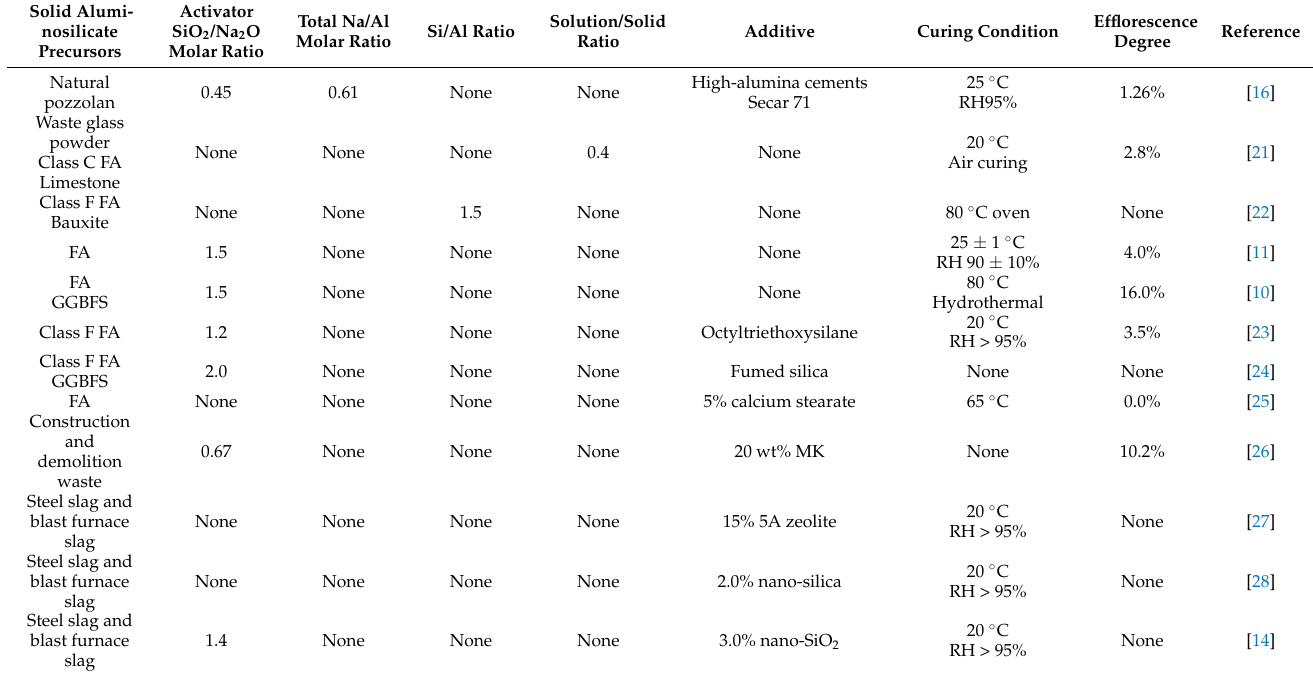
Table 1. The efflorescence degree of AAMs produced under different conditions.